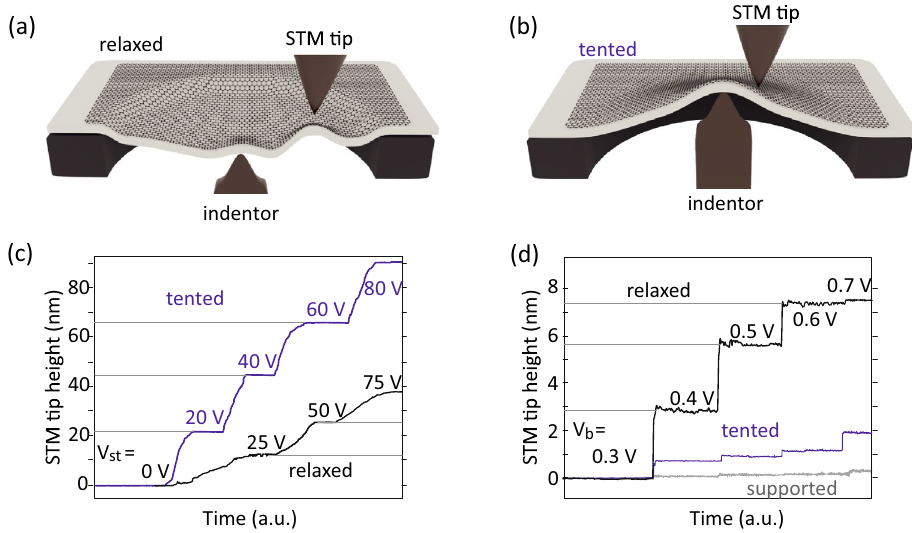
Figure 5. STM measurement on the graphene transferred on polyimide film. ( a ) Strain-free (relaxed) condition and ( b ) tented distortion induced by strain applied using the gearbox based control system. The sample height dependence on the piezoelectric actuator voltage (V st ), and the sample bias voltage (V b ) are shown in ( c ) and ( d ),